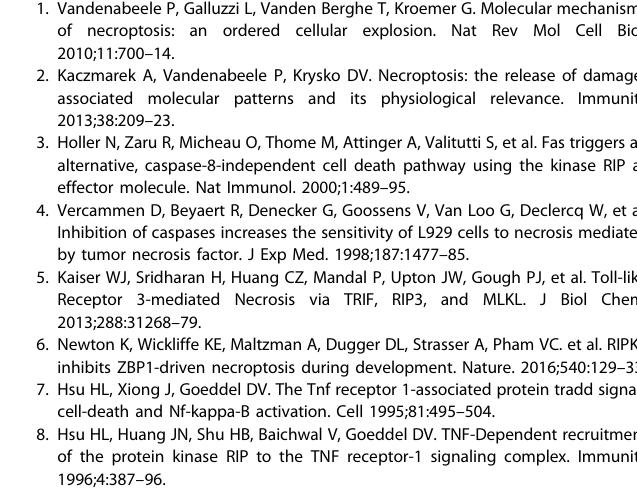
Fig. 6 PPP6C loss alleviates TNF-induced necroptosis in SIRS model. A Representative H&E staining of cecum from Ppp6c f/ + and Shh Cre/ + ; Ppp6c f/ + mice ( n = 3 each group at a time point) injected with TNF for the indicated time. Scale bar, 100 μ m. B Cecal proteins from Ppp6c f/ + and Shh Cre/ + ; Ppp6c f/ + mice injected with TNF for 8 h were analyzed by immunoblot with indicated antibodies. C A schematic model shows that PPP6C positively regulates TNF- induced necroptosis via TAK1-IKK α / β